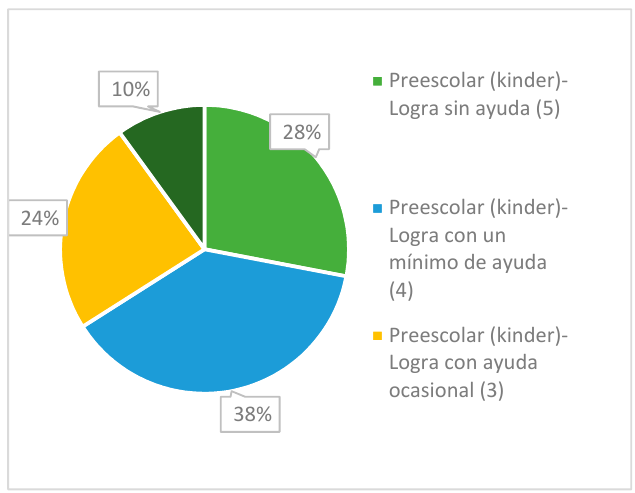
Figure 7. Valuation for the items of use of robotics resource and programming sequence.